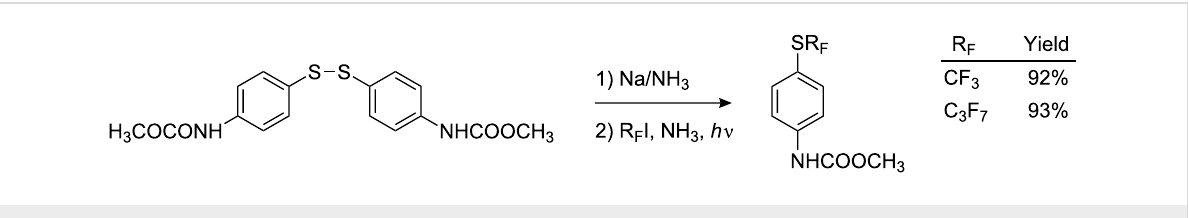
R R F Yields of ArSR F , %